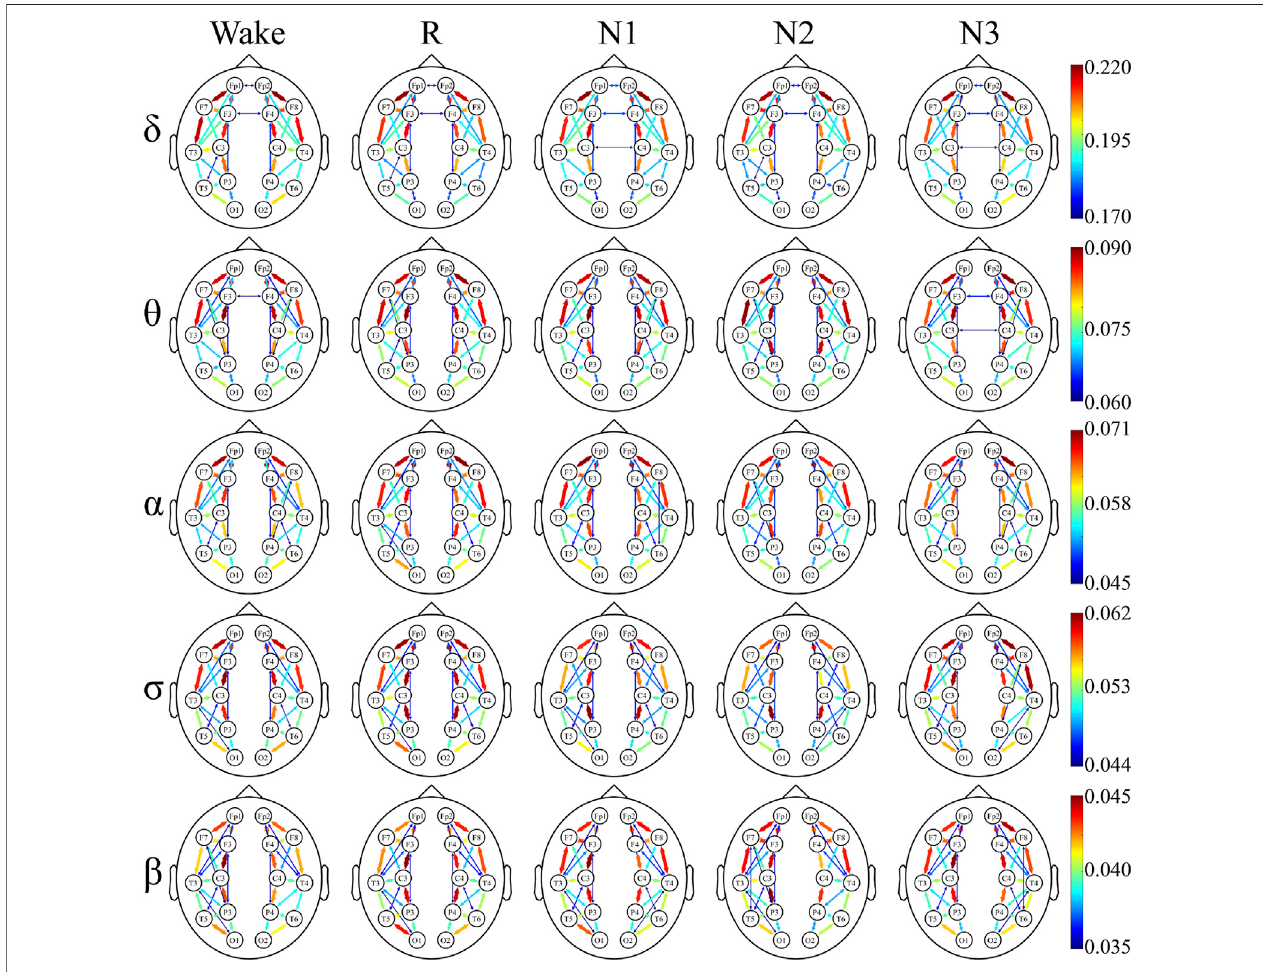
FIGURE 7 | Undirected connectivity graphs of the control group. Red indicates a higher link value. No link indicates that there is no direct functional connection between the two sites.